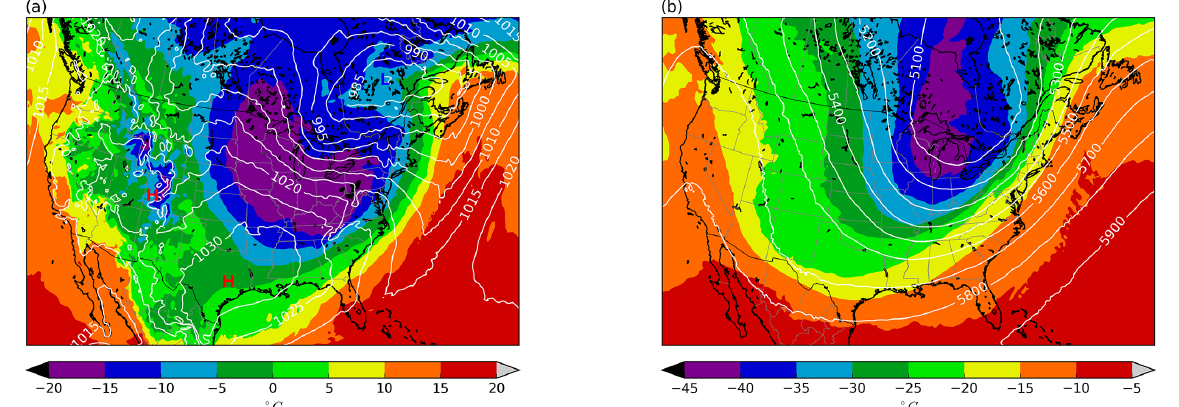
Figure 9. Synoptic situation on 18 November 2014 at 12:00UTC. Mean sea level pressure (contours, hPa) and 850hPa temperature (shades, ◦ C) (a) . Geopotential height (contours, m) and 500hPa temperature (shades, ◦ C) (b) .